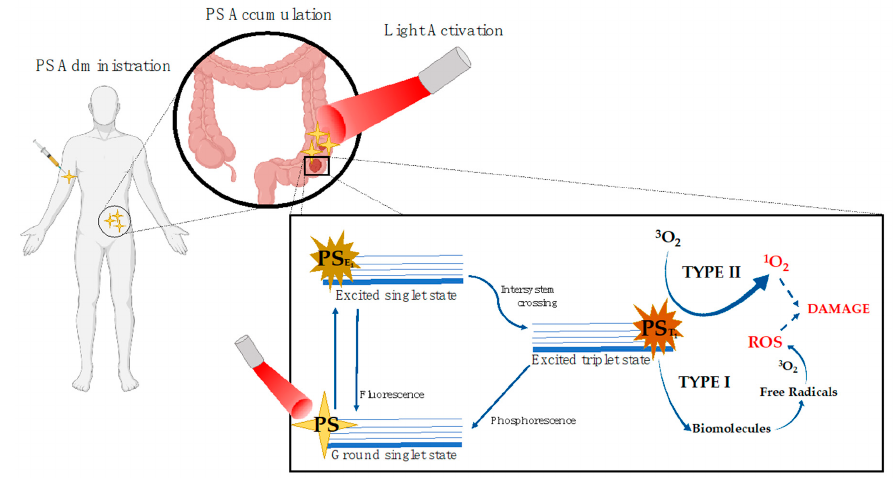
Figure 4. Photodynamic Therapy mechanisms. The photosensitizer (PS) is administered and distributed systemically. After, it starts to accumulate in the target damaged tissues. The PS is finally activated by the appropriate absorption wavelength light and the triplet state PS can go either type I or type II mechanism.